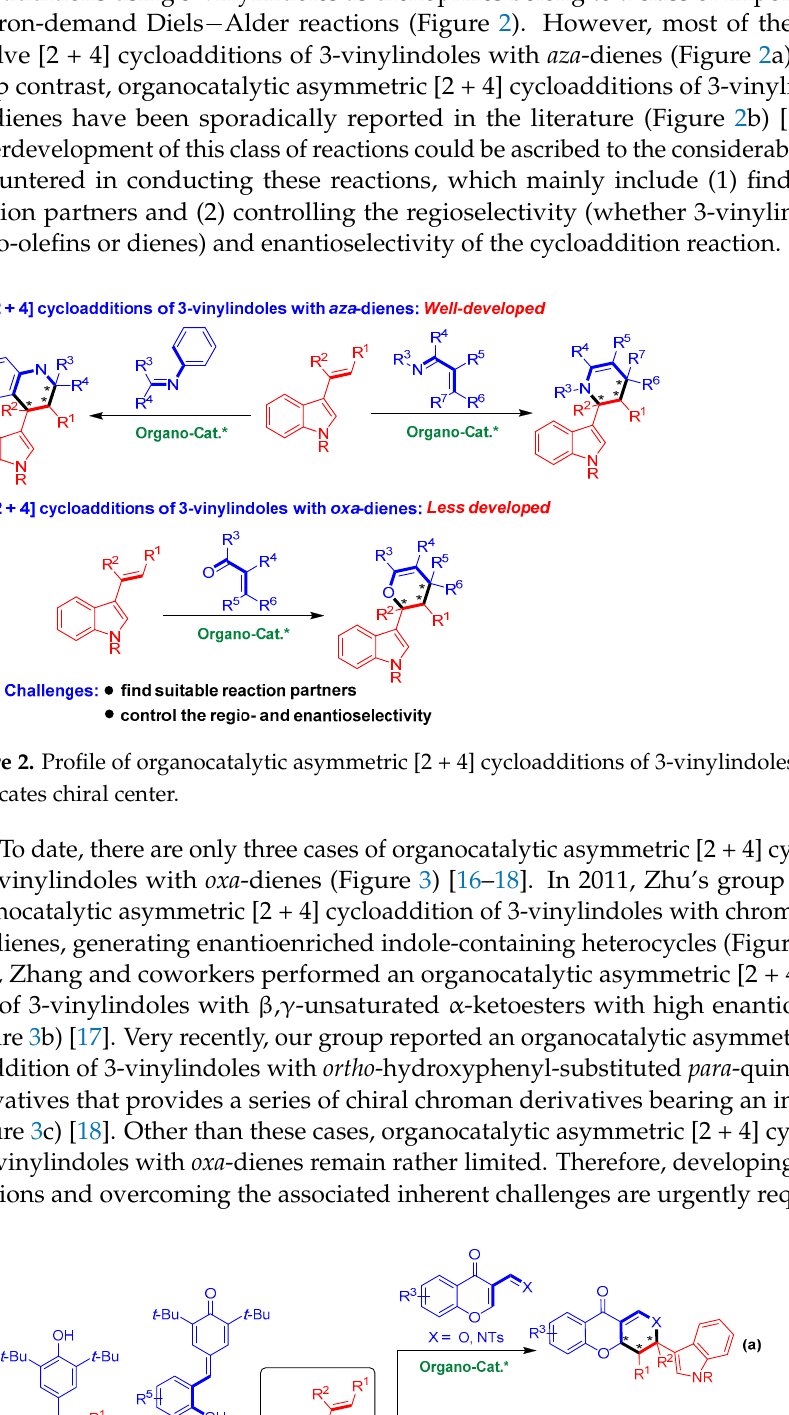
Figure 1. Profile of organocatalytic asymmetric reactions involving 3-vinylindoles.( a ) [4 + 2] Cy- cloaddition; ( b ) [2 + n] Cycloaddition; ( c ) Addition reaction; ( d) Alkenylation reaction. The asterisk * indicates chiral center.